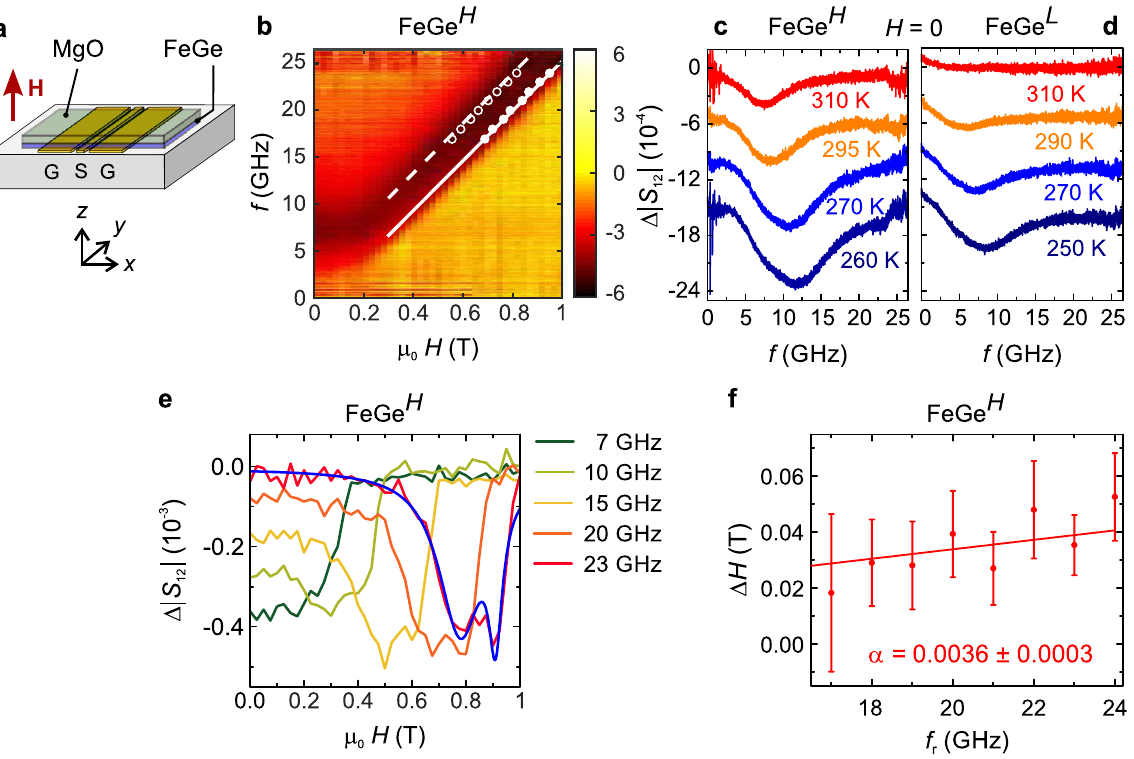
Figure 3. Broadband spectroscopy data. ( a ) The FeGe thin film sample is placed top-down onto the CPW consisting of a signal (S) and two ground (G) lines. The static field H is applied perpendicular to the thin film and the rf current applied to the conduction lines produces an rf field h x along x . ( b ) Colour-coded microwave absorption Δ | S 12 | spectra at different magnetic fields recorded at 310 K on a FeGe H sample. Darker regions correspond to stronger absorption. The dashed and solid lines correspond to a fit to PSSW modes, see text. Dots show fitted resonances (the error margin corresponds to the symbol size). ( c , d ) Zero-field absorption spectra at different temperatures recorded on a FeGe H and FeGe L sample, respectively. For the latter, no resonance is resolved above 290 K. Spectra are offset for clarity. The increased noise for f < 2.5 GHz and f > 22 GHz is attributed to the transmission properties of the microwave antenna. ( e ) Spectra at constant frequency, as a function of applied field at 310 K and exemplary fit of the sum of two Lorentzians (blue) to the 23 GHz data. ( f ) Field linewidth of the high-field mode (solid line in b ) with linear fit for determining the intrinsic damping parameter α intr